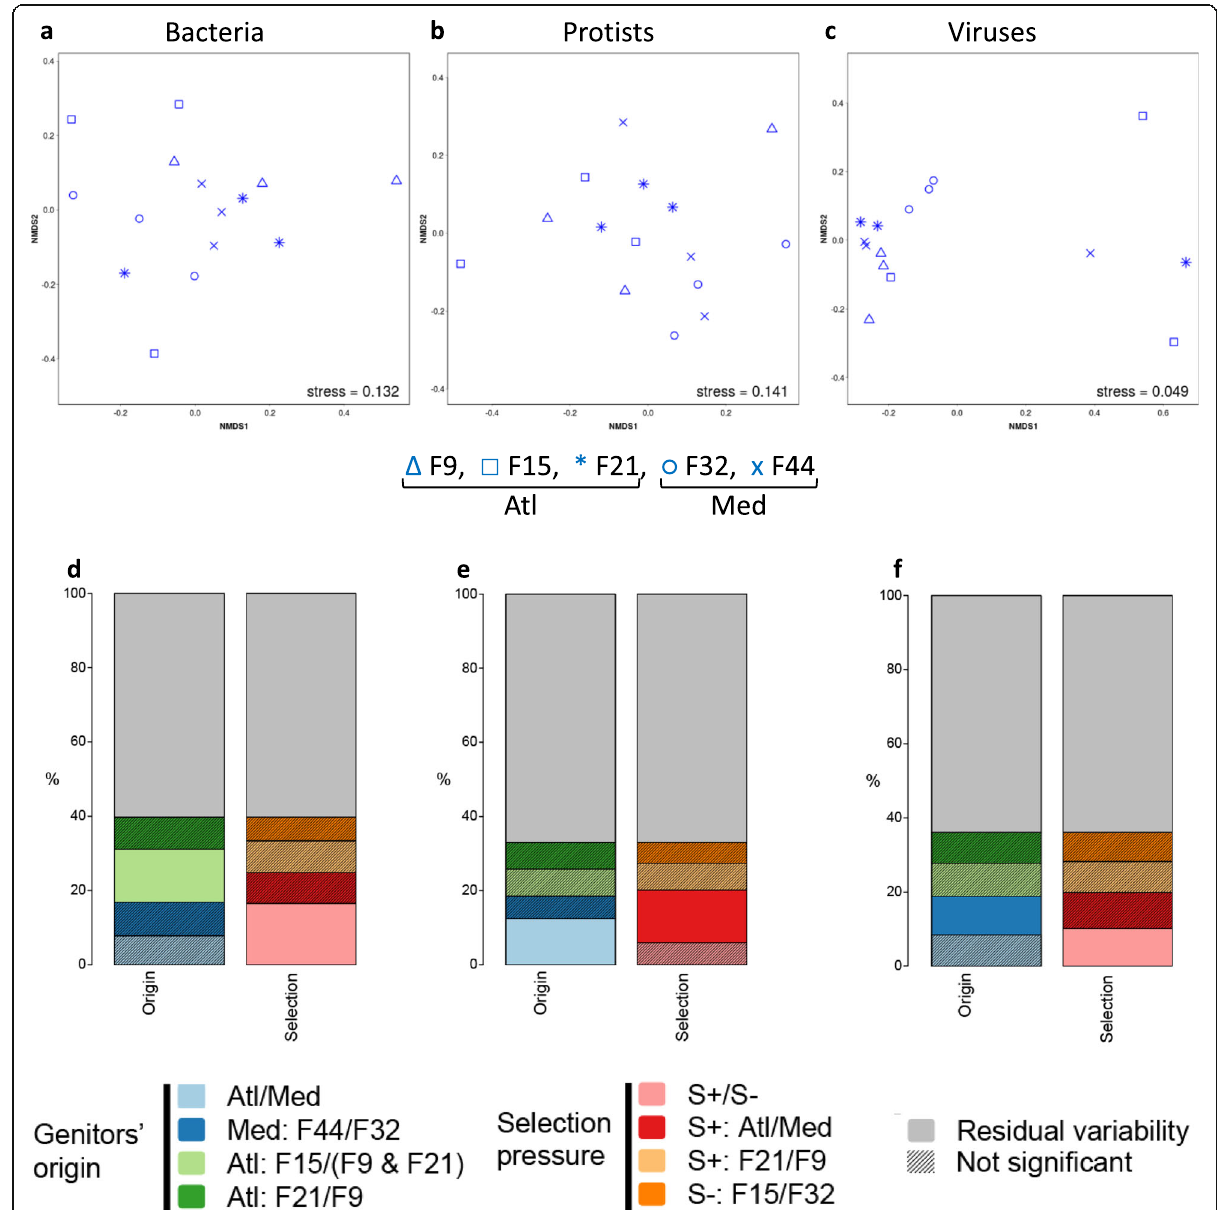
Fig. 4 Effect of oyster genotype on hemolymph microbiota. NMDS plots represent beta diversity based on Bray-Curtis dissimilarities for the bacterial ( a ), protistan ( b ) and viral ( c ) communities of oysters born and kept in the hatchery under controlled conditions. Bar plots are graphical representations of Permanova results showing the variation explained by oyster genetic background (genitors ’ origin and selection pressure experienced by genitors) for the bacterial ( d ), protistan ( e ) and viral ( f ) communities. Both bars represent the same analysis (model: ~ Family), but with two different sets of orthogonal contrasts (see Additional file 6 Table S5). The terms which are not significant are shown as shaded rectangles (for completeness), but should not be interpreted. Table on which the bar plots are based can be found in Additional File 10: Table S9. Bacterial and protistan diversity estimates are based on OTUs, viral on